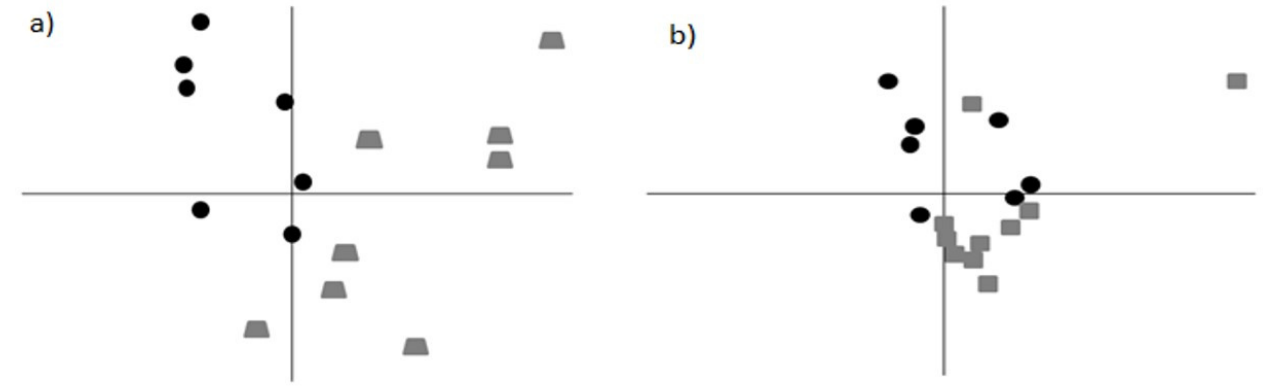
Figure 2. PCA of gene expression data. ( a ) Comparison between the control group (black circles) and SEA-affected horses (gray trapezoids). The x -axis and y -axis represent 55% and 11% of the total variance, respectively. ( b ) Comparison between the control group (black circles) and MEA-affected horses (gray squares). The total variance was represented by 40% of the x -axis and by 21% of the y -axis.